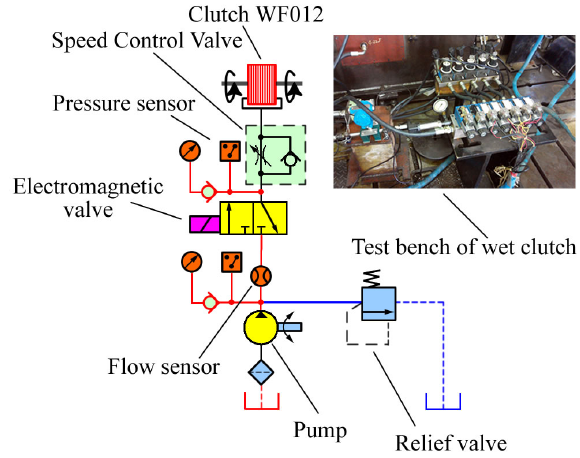
Figure 4. Test circuit of wet clutch